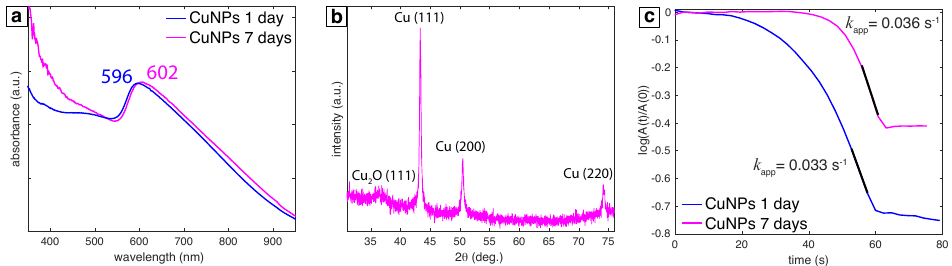
Figure 6. ( a ) UV-vis absorbance spectra measured at 1 day (blue) and 7 days (magenta). ( b ) XRD spectra for 7 day sample. ( c ) Time dependence of the absorbance of p -nitrophenolate ions at 400 nm for 1 day (blue) and 7 days (bright pink) samples; black portion of line is where k app (s − 1 ) is